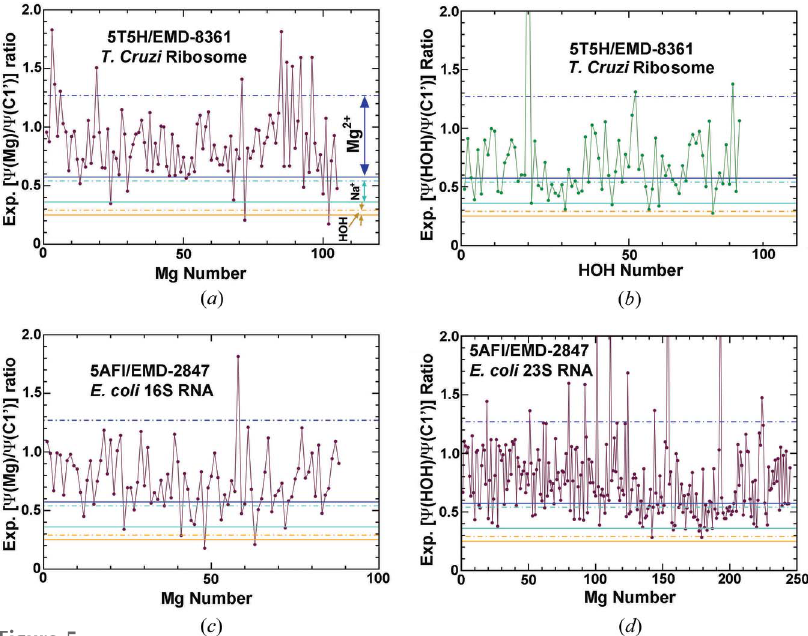
Figure 5 Application of the ESP ratios to two ribosome structures plotted as a function of the sequential order number of Mg 2+ or H 2 O in the coordinate files. ( a ) Mg 2+ in the 5t5h structure. ( b ) H 2 O in the 5t5h structure. ( c ) Mg 2+ bound to the 16S rRNA in the 5af1 structure. ( d ) Mg 2+ bound to the 26S rRNA in the 5af1 structure. The upper limits (dashed lines) of Mg 2+ (blue), Na + (cyan) and H 2 O (orange) are derived from the theoretical plot at Mg-J1 site assuming B = 41.25 A˚ 2 . The lower limits (solid lines) are from